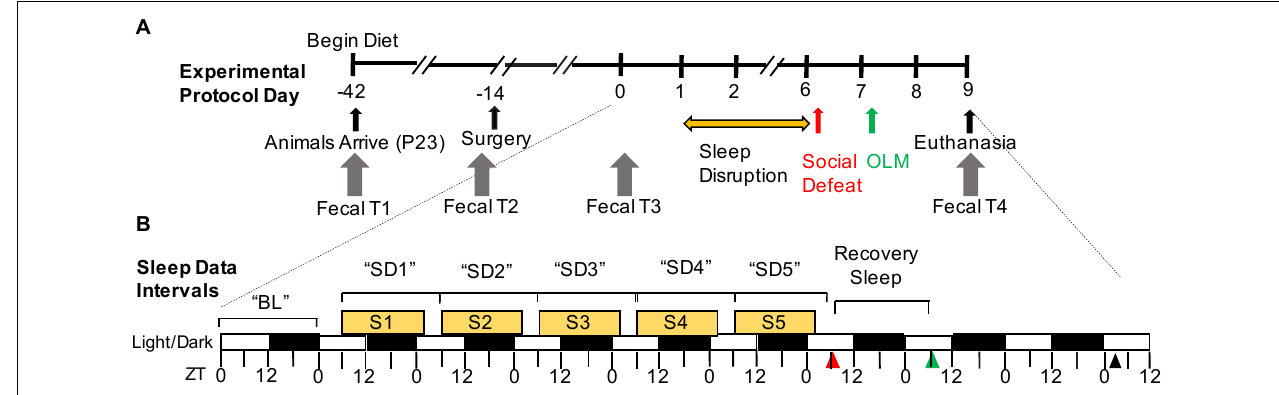
FIGURE 1 | Experimental timeline. (A) Overview of the experimental protocol. Experimental protocol days are depicted along the axis of the timeline. The yellow horizontal arrow denotes the sleep disruption portion of the protocol. The red and green arrows denote social defeat and object learning memory, respectively. Days of fecal sample collection are indicated with gray arrows. (B) Detail of indicated period that includes the sleep disruption protocol, social defeat stress (red arrowhead), object location memory (green arrowhead), and terminal sample collection (black arrowhead). Tick marks along the bottom of the timeline axis indicate Zeitgeber time (ZT) on that day, white/black rectangles indicate 12-h light/dark phases, and yellow rectangles indicate time periods of sleep disruption for the sleep-disrupted groups (ZT6-ZT2). EEG/EMG recording intervals, as used in the forthcoming figures, are indicated above the timeline. BL, baseline; OLM, object location memory; P, postnatal day; S, 20-h sleep disruption window; SD, 24-h sleep disruption day; ZT, Zeitgeber